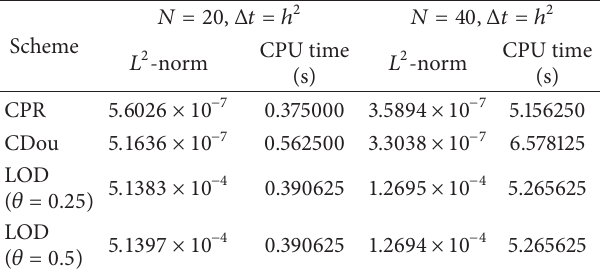
Table 2: The 𝐿 2 -norm and CPU time for the fourth-order schemes.